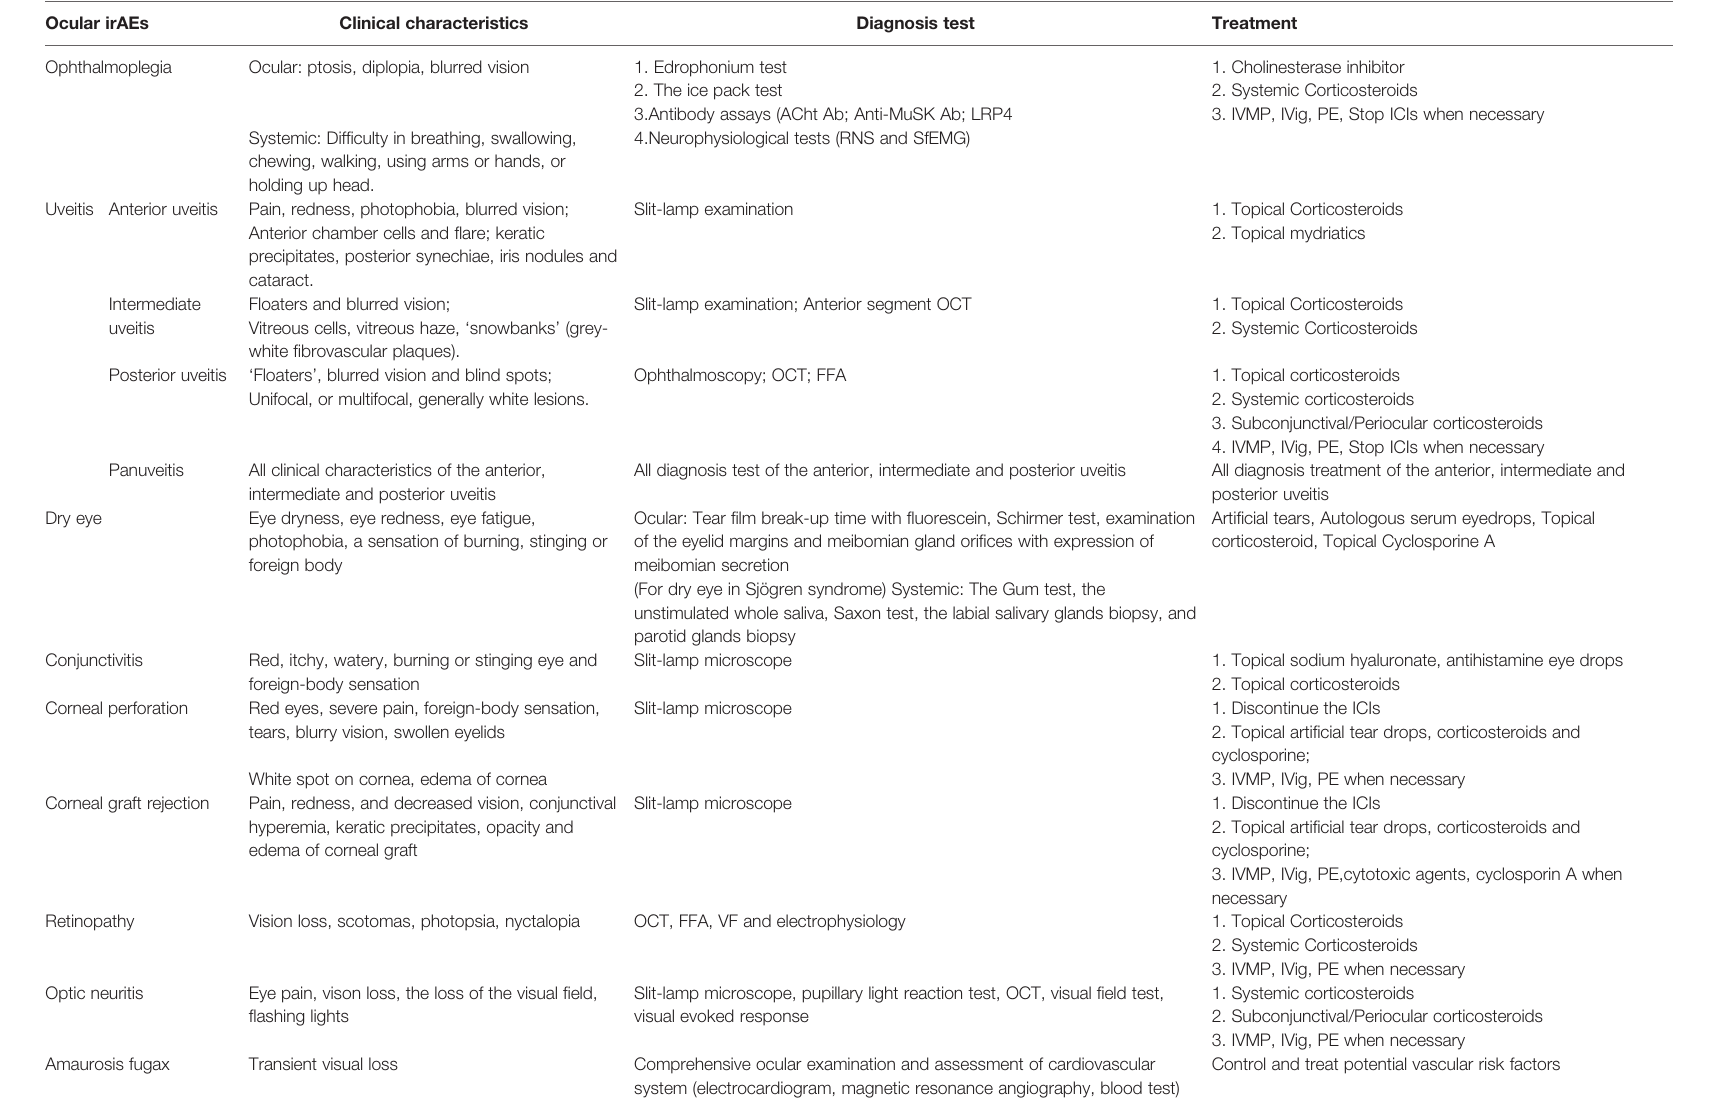
TABLE 3 | The clinical characteristics, diagnosis, and treatment for ocular irAEs on ICIs therapy in lung cancer. Ocular